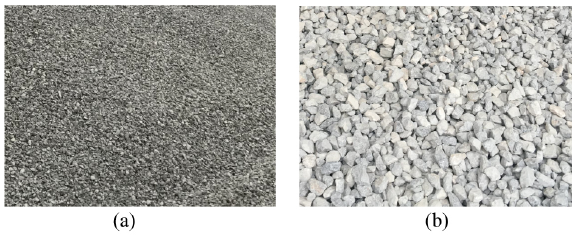
Figure 4. Two types of piles. ( a ) Small coarse gravel. ( b ) Medium coarse gravel.